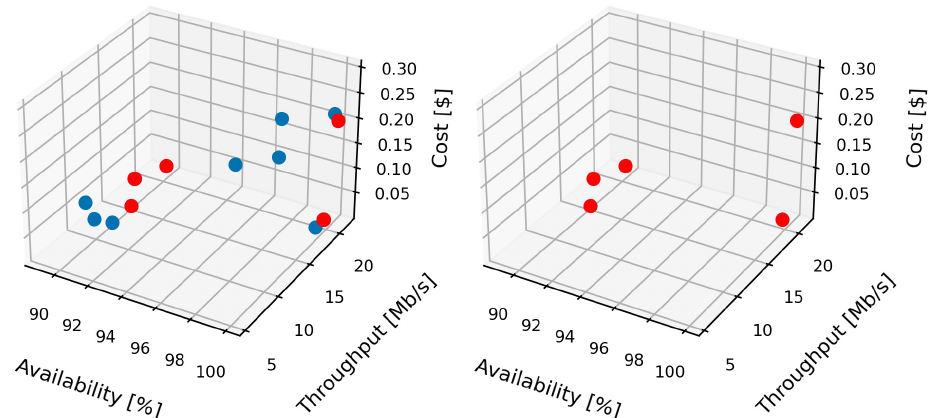
Figure 5. Pareto front derived from the experimental evaluation with existing storage nodes located in Europe. The plot on the left illustrates all available Fog storage nodes, whereas the plot on the right illustrates only the non-dominated nodes that form the Pareto front.